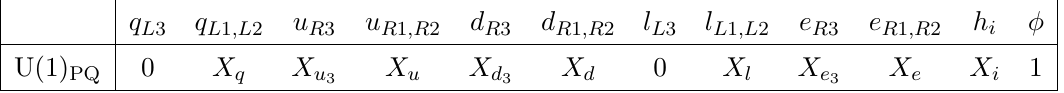
Table 5 . PQ charge